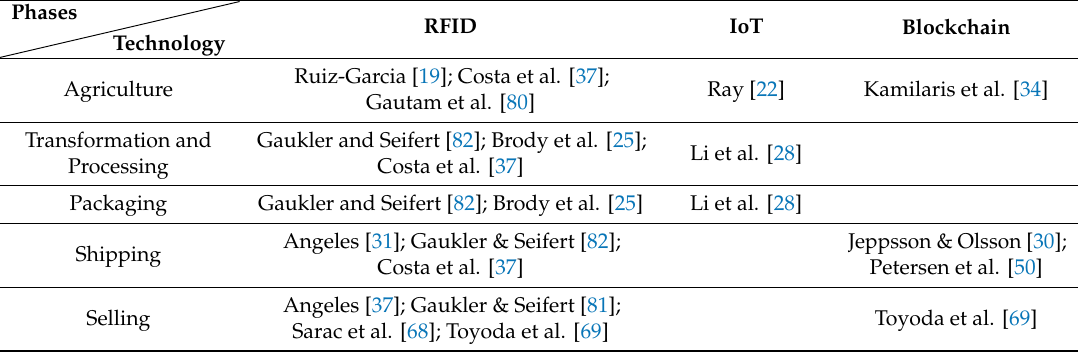
Table 2. Widely used technologies and their implementation in phases of the food supply